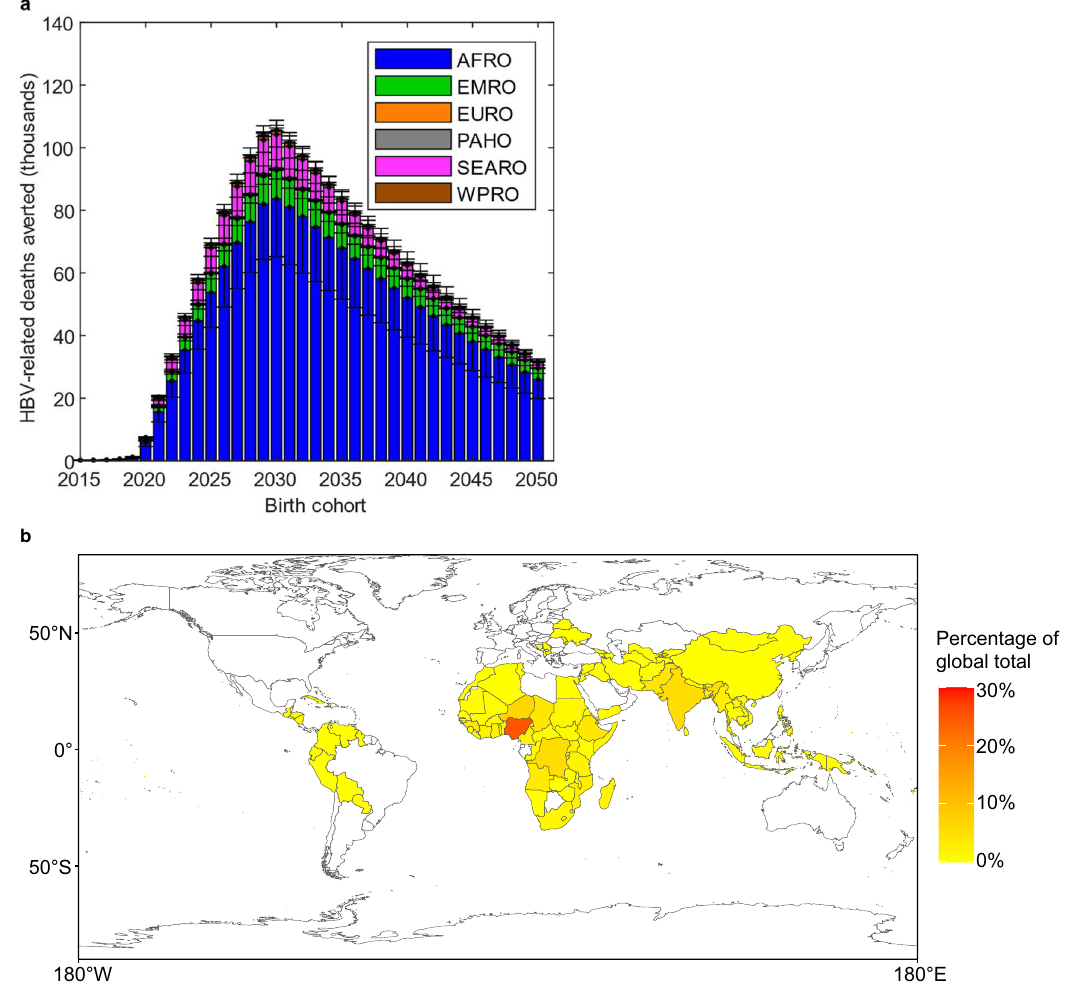
Fig. 3 The impact of timely HepB-BD scale-up on HBV-related deaths. a HBV-related deaths averted in each WHO region (mean and 95% credibility intervals) in the birth cohorts for years 2015 to 2050, in the scenario in which timely HepB-BD coverage is scaled up to ≥ 90% by 2030 in each country (the HepB-BD scale-up scenario) compared to the status quo HepB3 & HepB-BD scenario. Results are the sums within WHO regions from all modelled countries of n = 200 model outcomes resulting from 200 independent draws from the posterior distribution of each country. b Percentage of global total HBV-related deaths averted in the 2020 to 2030 birth cohorts that occurs in each country if timely HepB-BD coverage is scaled up to ≥ 90% by 2030 (the HepB-BD scale-up scenario) relative to the status quo HepB3 & HepB-BD scenario. The six WHO regions AFRO, EMRO, EURO, PAHO, SEARO, and WPRO are shown in Supplementary Fig. 1. HBV hepatitis B virus, HepB3 infant HBV vaccine series, timely HepB-BD timely birth dose, WHO World Health